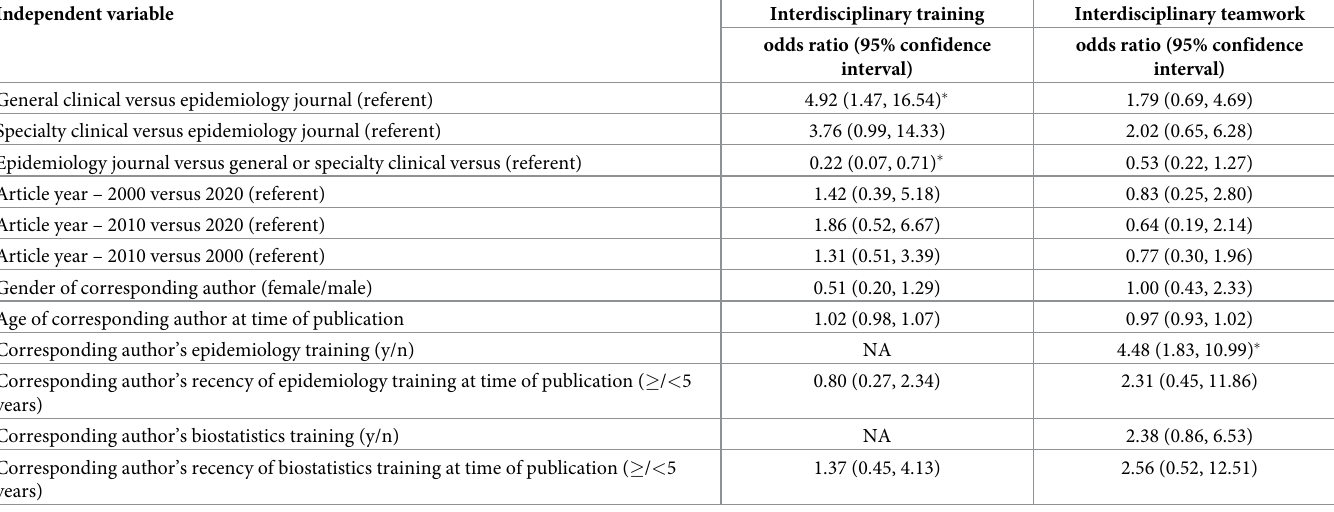
Table 2. Bivariate associations between independent variables and interdisciplinary training a and teamwork b